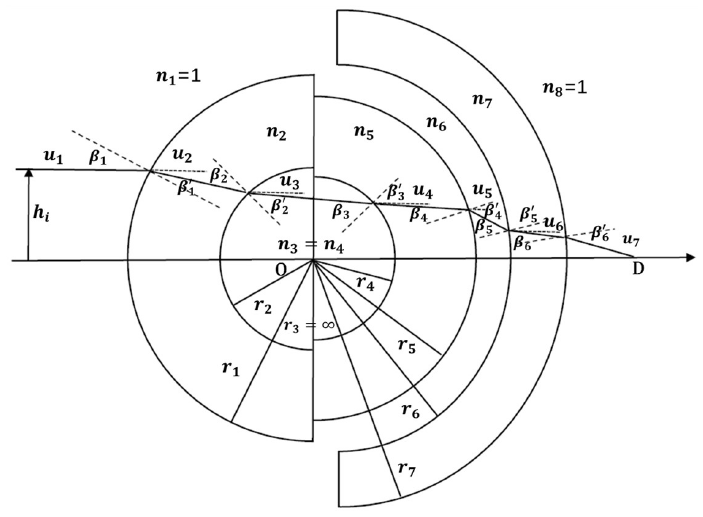
Figure 3. Optical path diagram of the monocentric lens.